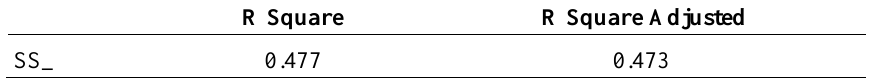
Table.4. Coefficient of